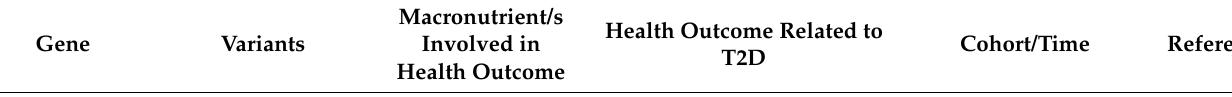
Macronutrient/s Health Outcome Related to Involved in Cohort/Time Reference T2D Health Outcome Carbohydrates